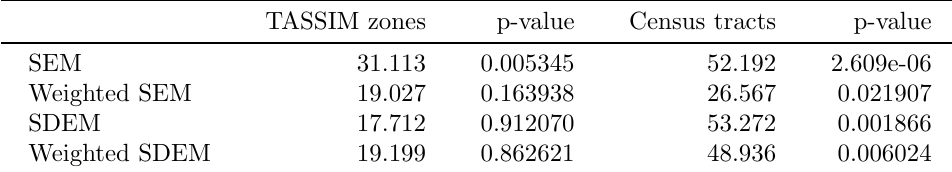
Table A.9: Hausman tests for differences between least squares and spatial error an spatial Durbin model coefficients for weighted and unweighted models and the 489 census tract data set and the 96 TASSIM zone data set.